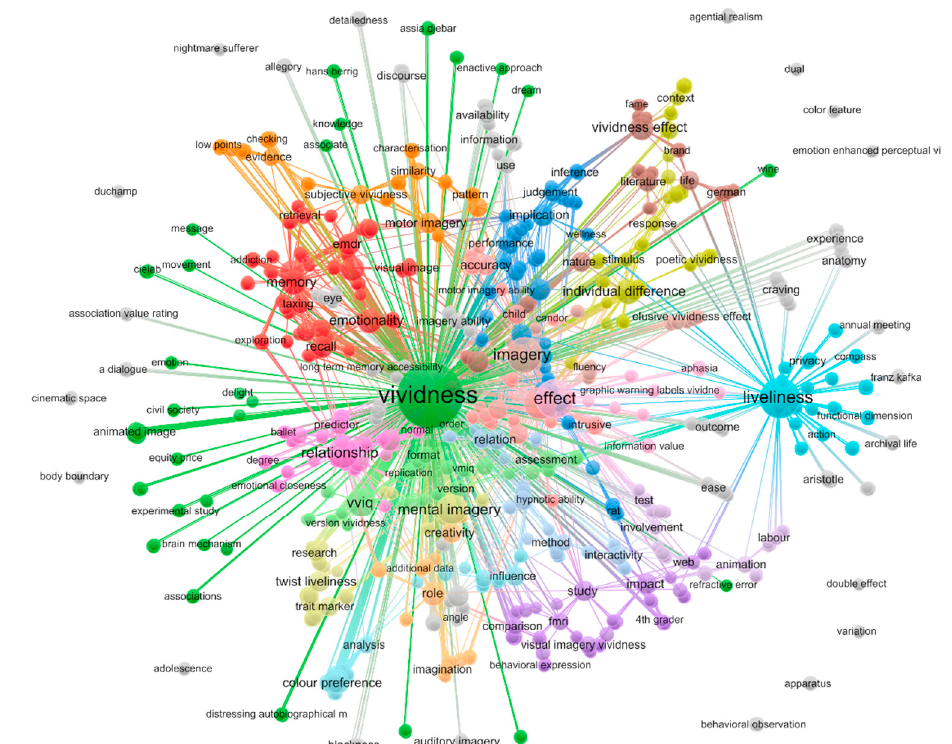
Figure 4. Co-occurrence network of noun phrases based on articles with “vividness” in the title.